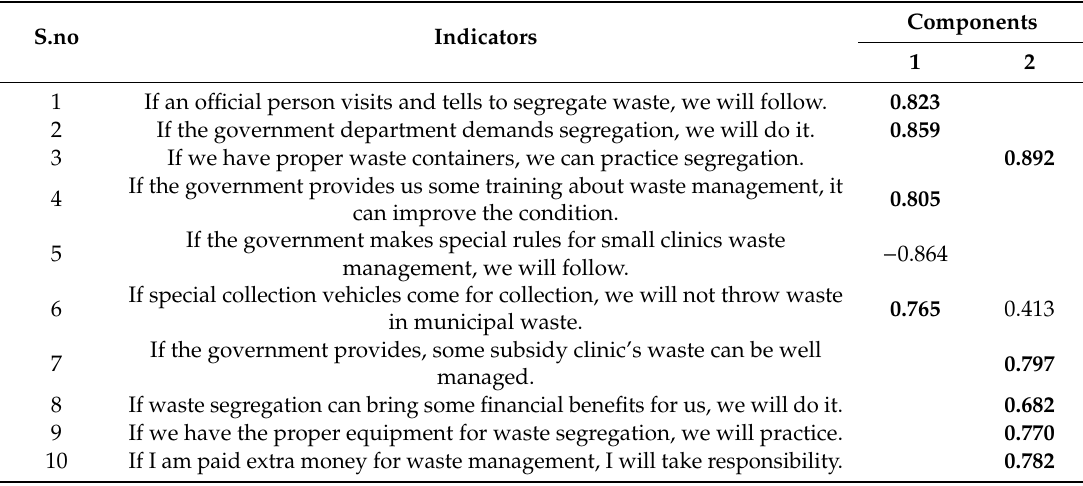
Table 5. Rotated component matrix—exploratory factor